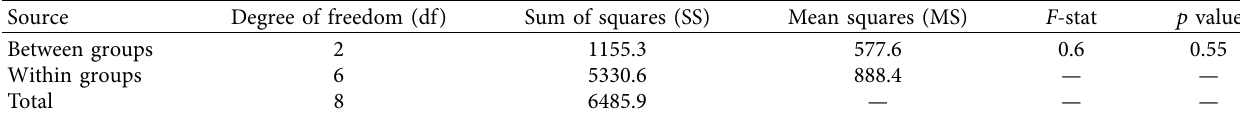
Table 9: ANOVA table of SOC stock between soil layers for upper mixed hardwood forest.